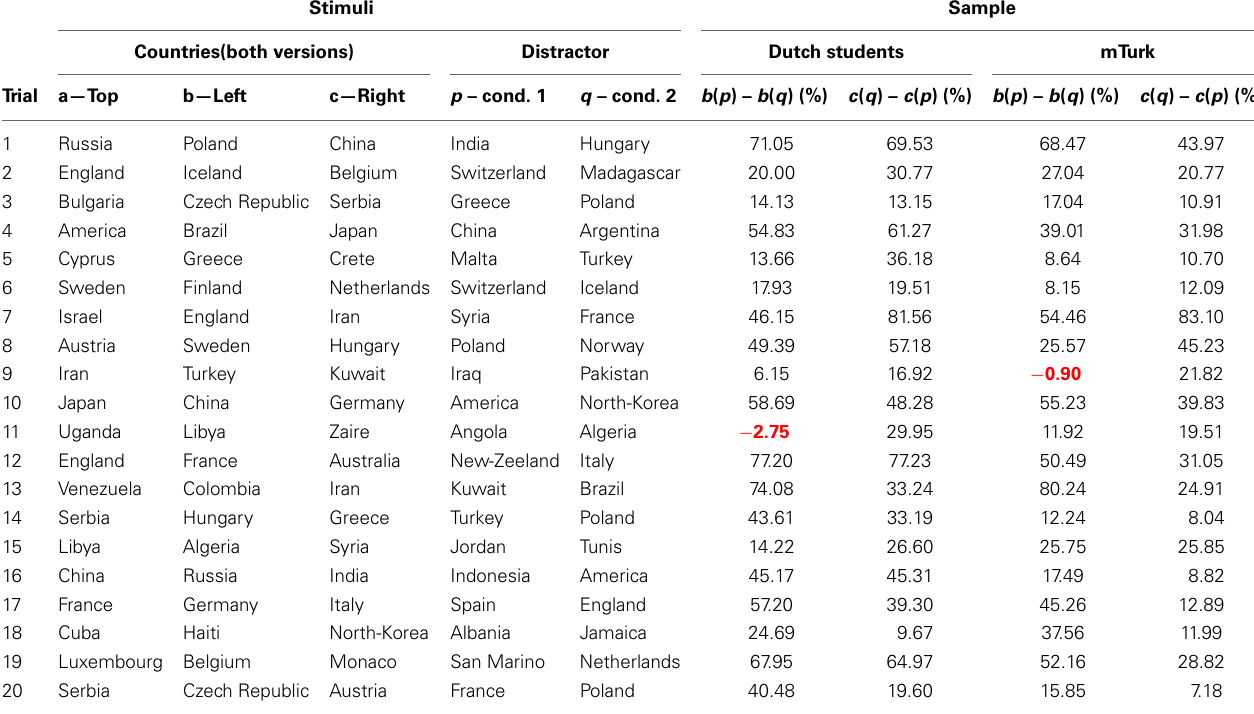
Table 2 | Overview of categorization data in Study 2a and 2b.